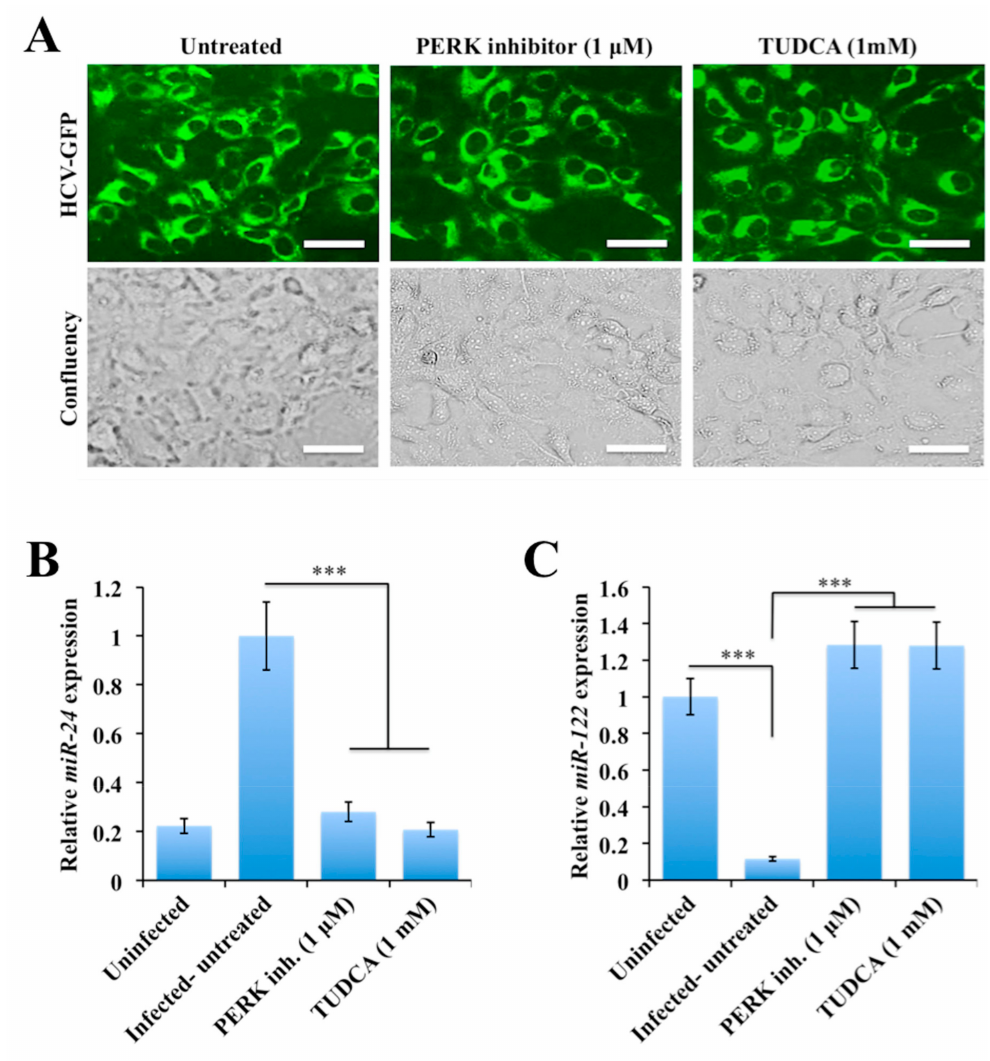
Figure 5. The expression of miR-24 and miR-122 in hepatitis C virus (HCV)-infected Huh-7.5 cells in the presence of the protein kinase RNA-like ER kinase (PERK) or endoplasmic reticulum (ER) stress inhibitors. Infected Huh-7.5 cells were treated with the PERK inhibitor or ER stress inhibitors for 72 hours. Cells were collected and the expression levels of miR-24 and miR-122 were measured by real-time RT-PCR. ( A ) Shown are expression levels of HCV-green fluorescence protein (GFP) chimera in day 9 HCV culture by fluorescence microscopy before and after treatment. ( B ) Shown are amounts of miR-24 before and after treatment with the PERK inhibitor or tauroursodeoxycholic (TUDCA) in HCV-infected culture. ( C ) The levels of miR-122 in uninfected and infected Huh-7.5 cells treated with either with the PERK inhibitor or TUDCA. The results are expressed as the mean ± standard deviation (SD) of three experiments. Error bars represent SD. p -values were calculated by ANOVA between different groups as compared to untreated HCV-infected group. *** p -value < 0.001. Original magnification × 40. Scale bars = 25 µ